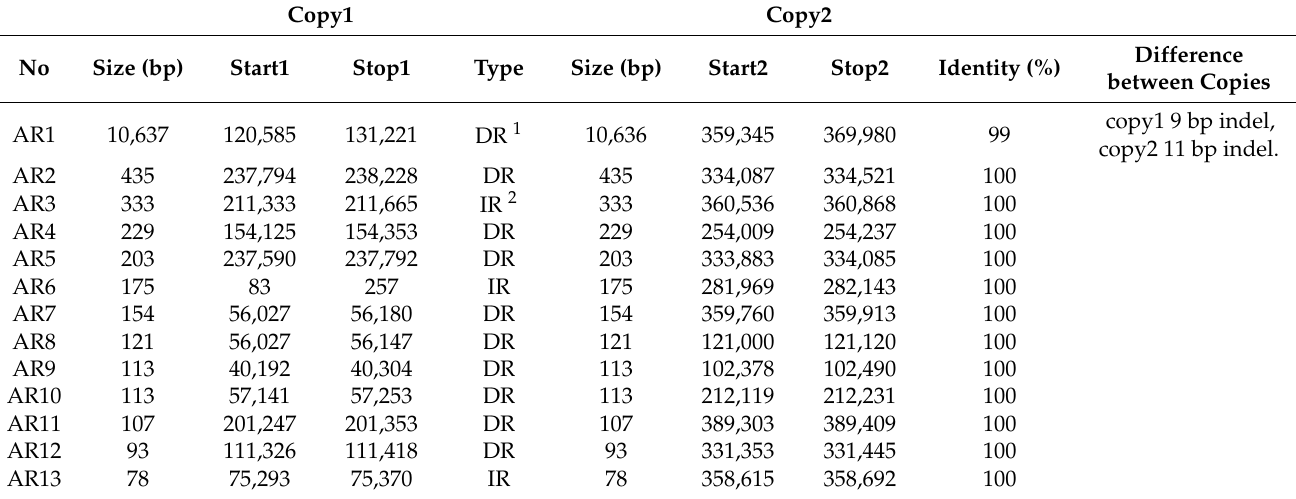
Table 2. Repeat sequences (>50 bp) in the mitogenomes of CMS line